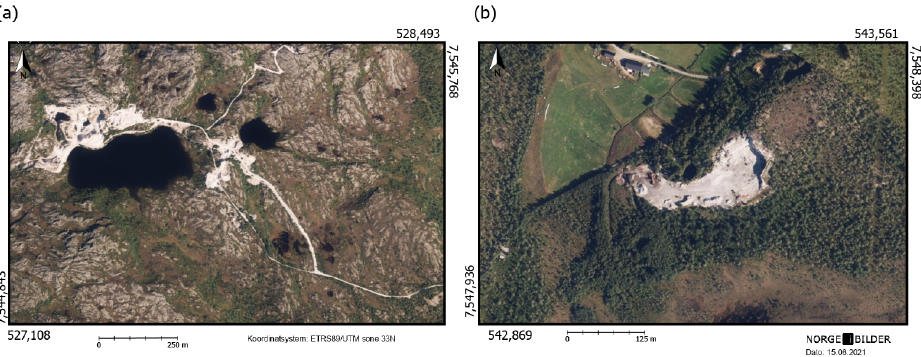
Figure 2. High-resolution aerial photographs of the ( a ) Håkonhals and ( b ) Jennyhaugen mines that were used as target areas in this study. Adapted with permission from Norge I bilder [23].